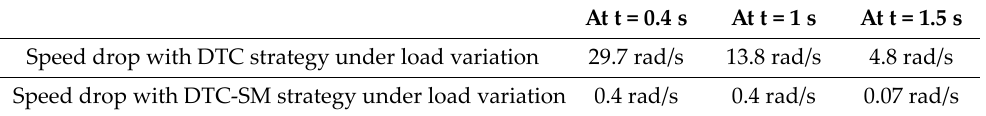
Figure 10. Motor speed with DTC and DTC − SM techniques under load torque variations. The speed responses of the machine with both developed control techniques converge towards their reference values. However, during the load torque’s sudden application (Figure 8), we recorded speed drops, which are given in Table 2. Table 2. Speed drop of the IM under both control strategies in different operating